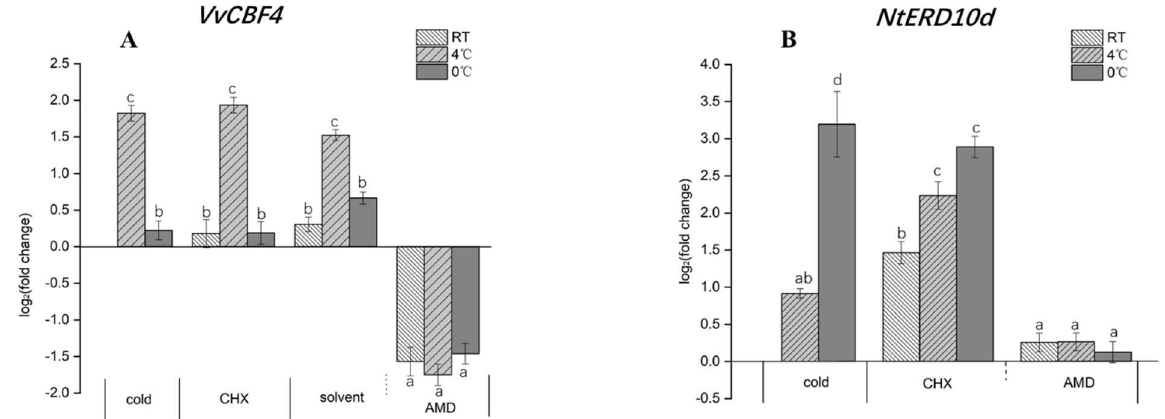
Figure 6. Role of transcription for the expression of VvCBF4 and NtERD10d . Steady-state transcript levels for the foreign VvCBF4 ( A ) and the endogenous COR transcript NtERD10d ( B ) were measured after 24 h incubation of VvCBF4 overexpressor cells and non-transformed BY-2, either at 25 °C (RT), chilling (4 °C), or freezing (0 °C) stress after pre-treatment for 2 h with either the transcription inhibitor Actinomycin D (AMD, 50 μg/mL) or the translation inhibitor Cycloheximide (CHX, 100 μg/mL). The solvent control of AMD was 2.5% EtOH, while CHX was diluted in an aqueous stock. Data are normalised to the expression levels under room temperature without any of the inhibitors and represent means ± SE of three independent experiments in technical triplicate. Statistically significant differences are represented as different letters with Fisher’s LSD test ( p < 0.01).